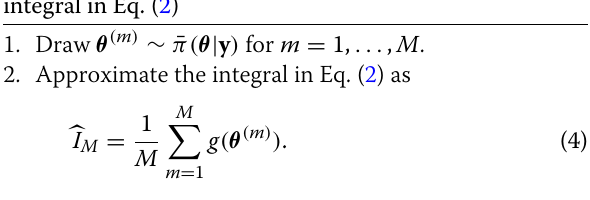
Algorithm 1 Monte Carlo (MC) approximation of the integral in Eq.